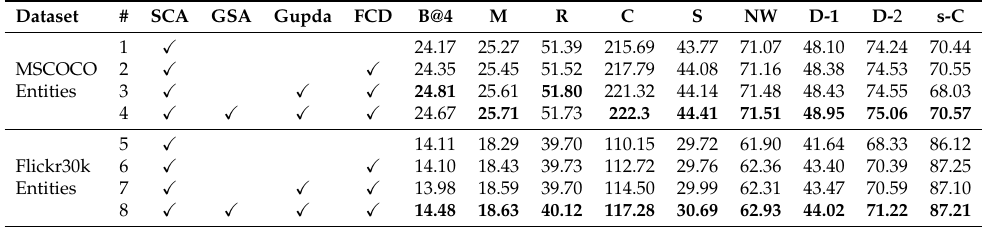
Table 2. Comparison of variants for proposed modules in decoder on MSCOCO Entities. ( (cid:88) ) indicates “used” (SCA:semantic content attention; GSA:graph structure attention; gupda:graph updating; FCD: Fusion Constraint Decode). Bold for the best.